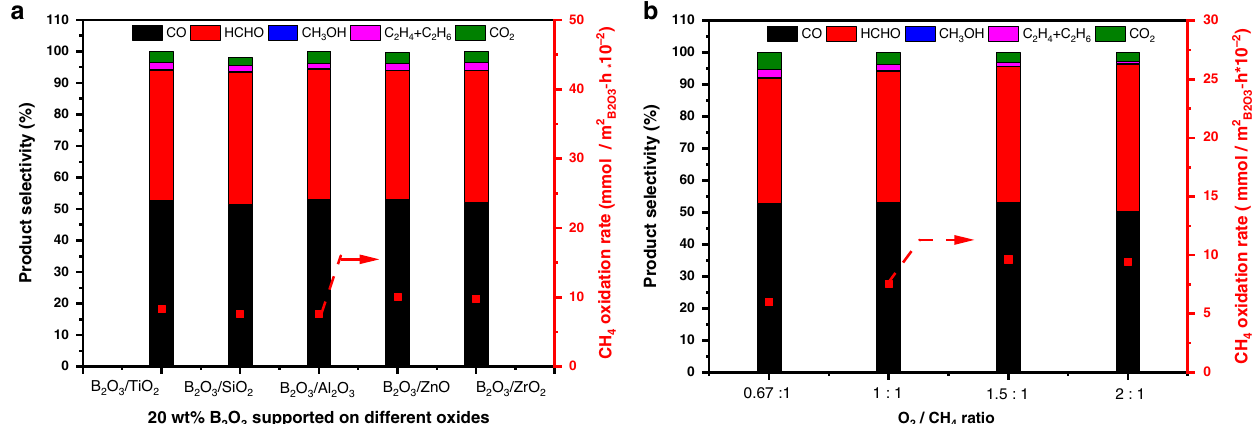
Fig. 1 Methane oxidation rates and selectivity on supported B 2 O 3 catalysts. a Effects of oxide support on 20 wt% B 2 O 3 -based catalysts. b Effects of O 2 /CH 4 ratio on 20 wt% B 2 O 3 /Al 2 O 3 . Reaction conditions: 550 °C, 32 kPa P CH4 , 32 kPa P O2 for ( a ) or 21 – 64 kPa P O2 for ( b ), gas composition balanced with N 2 , ~6% CH 4 conversion was achieved by adjusting the space velocity within a range of 1500 – 50000 mL g cat . − 1 h − 1 . The methane oxidation rates reported here were normalized by the exposed surface area of B 2 O 3 . The bars in a and b denote product selectivities (CO in black, HCHO in red, CH 3 OH in blue, C 2 H 4 and C 2 H 6 in magenta, and CO 2 in green), and the red square in a and b denote methane oxidation